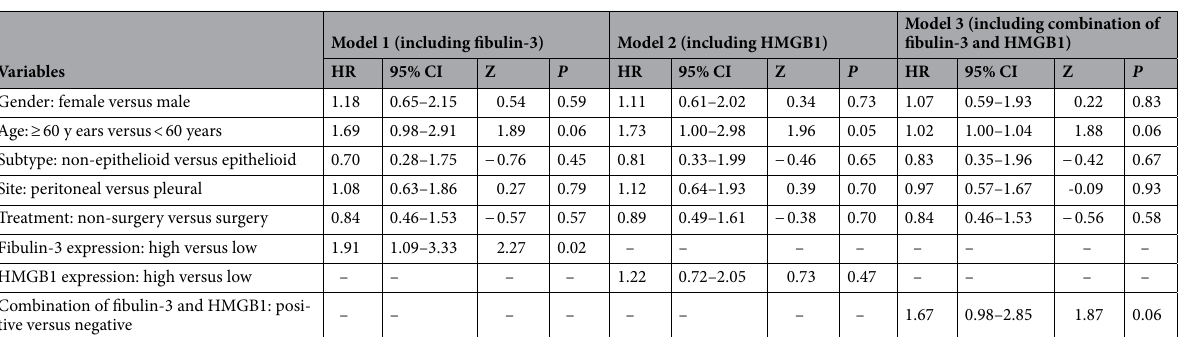
– – Table 2. Multiple cox regression models of overall survival in mesothelioma patients. HMGB1 was excluded from model 1, and fibulin-3 was excluded from model 2 due to collinearity between tissue expression of fibulin-3 and HMGB1. HR : hazard ratio; CI : confidence interval.